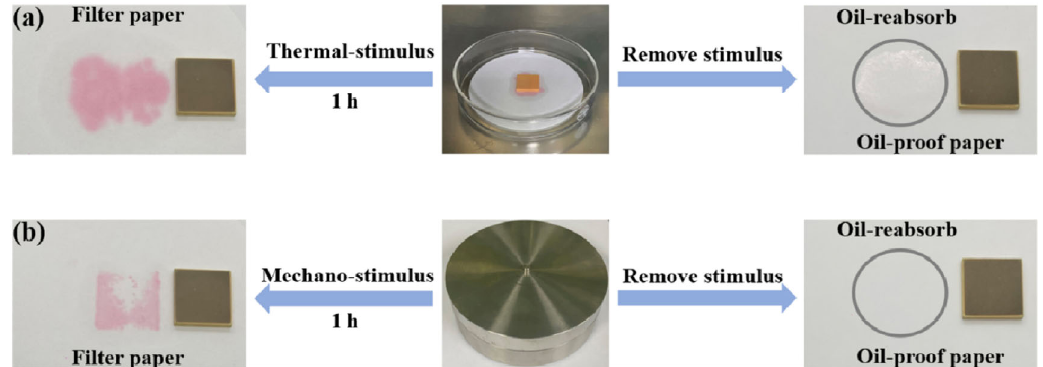
Fig. 12 Oil release of OCHPPI-T100 under (a) thermal-stimulus or (b) mechano-stimulus and capillary force induced oil reabsorption.